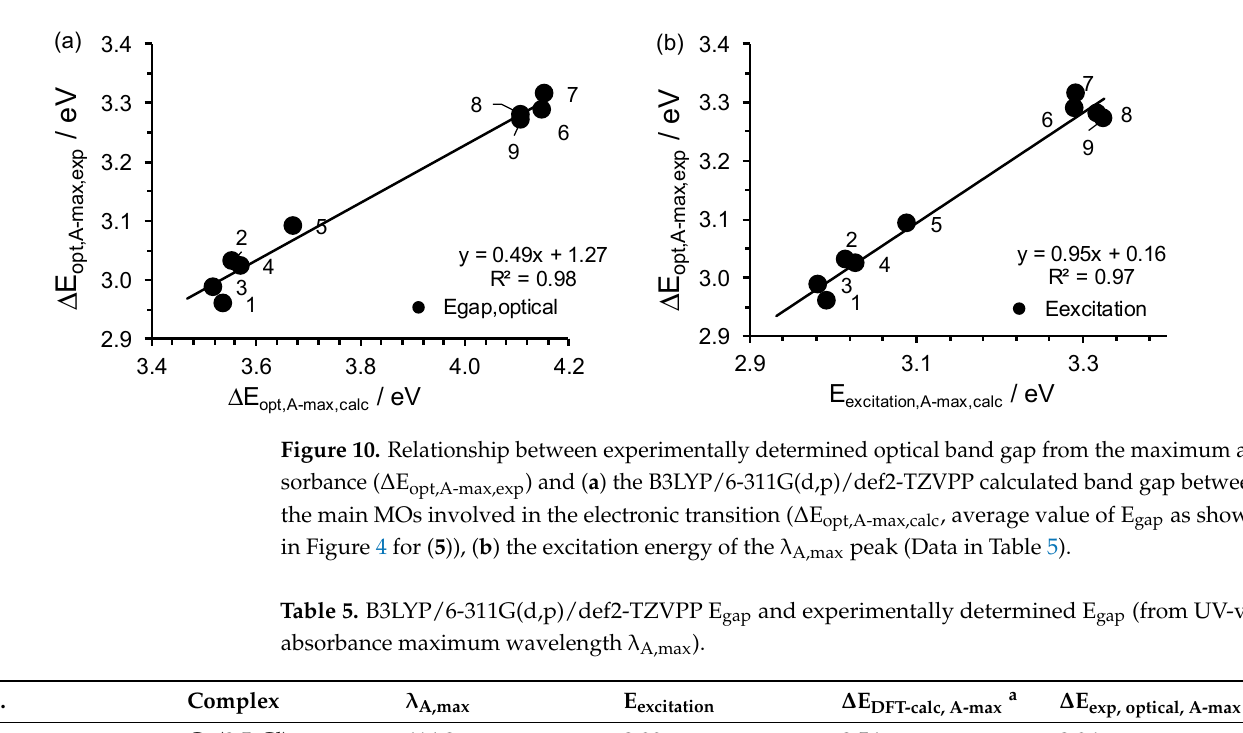
Figure 9. ( a ) The experimental UV of ( 5 ) in DMSO illustrating the determination of the onset (469 nm) and maximum absorbance (401 nm) positions that were used to calculate the experimental op- tical band gap ( Δ E opt ). ( b ) Tauc plot of ( 5 ) showing the determination of the experimental optical band gap ( Δ E opt,Tauc ).